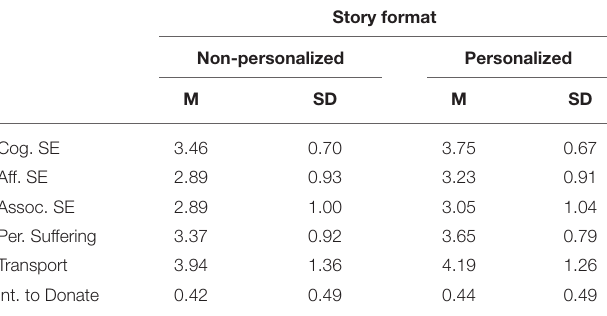
TABLE 3 | Descriptive statistics for non-personalized and personalized